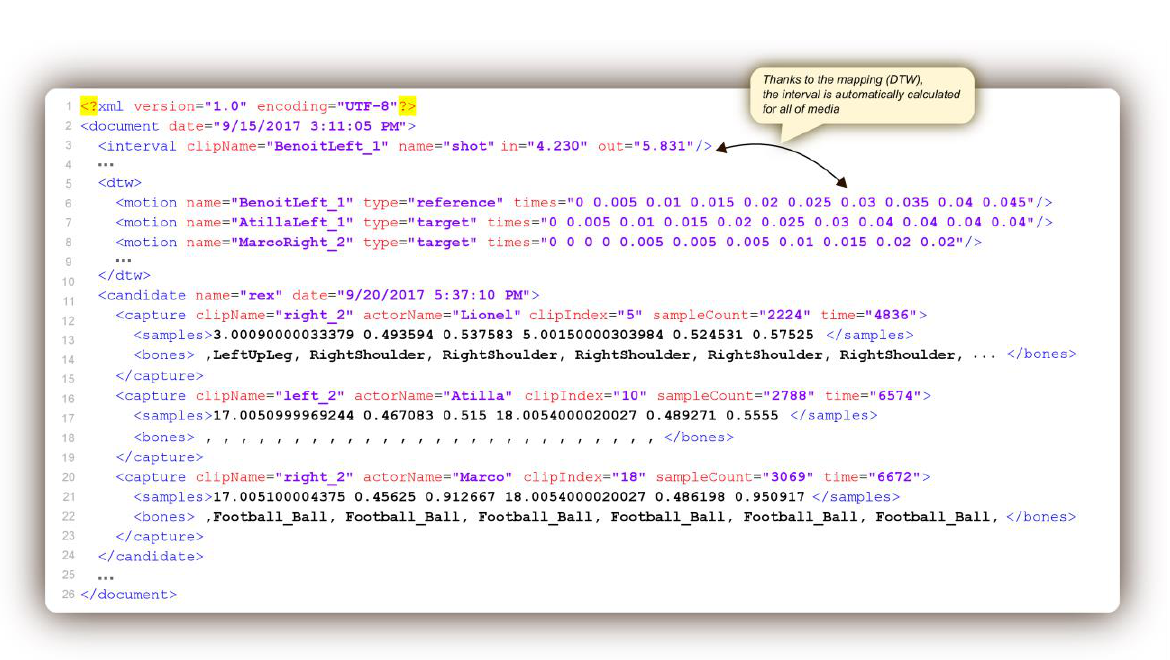
Figure 8. Example of input file.